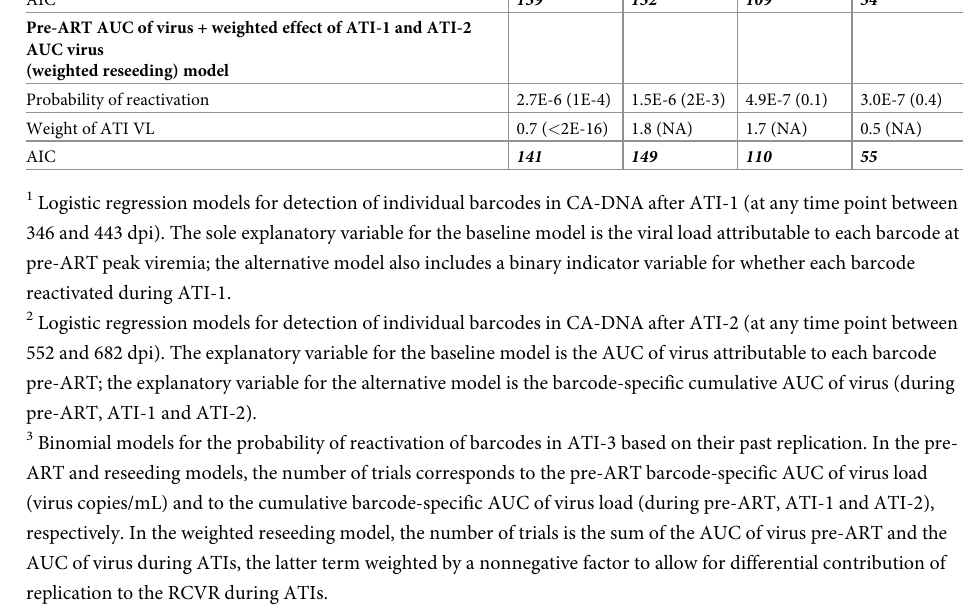
Cumulative (pre-ART + ATI-1 + ATI-2) AUC of virus (reseeding) model Probability of reactivation